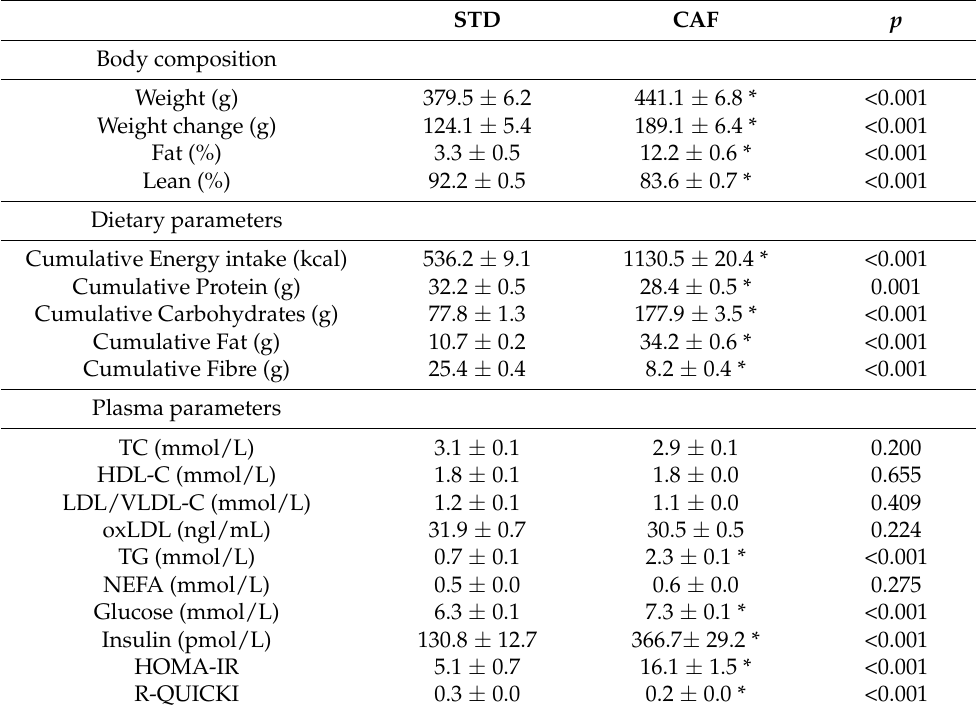
Table 3. Body composition and dietary and plasma parameters of rats fed a standard (STD) or cafeteria (CAF) diet at the 8th week of the study. STD CAF p Body composition Weight (g) 379.5 ± 6.2 <0.001 Weight change (g) 124.1 ± 5.4 Fat (%) <0.001 Lean (%) 92.2 ± 0.5 <0.001 Dietary parameters Cumulative Energy intake (kcal) 536.2 ±